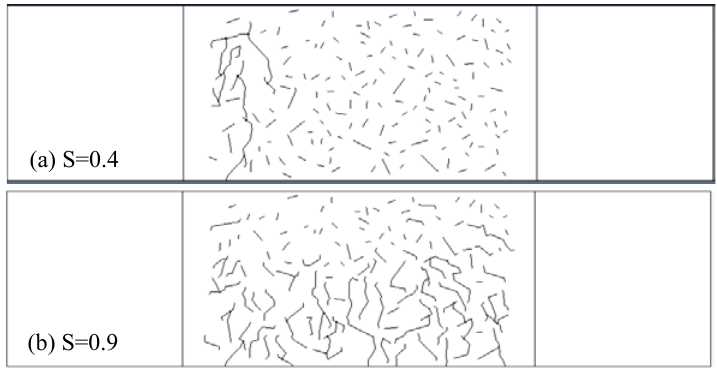
Figure 10. Stress level and failure pattern.